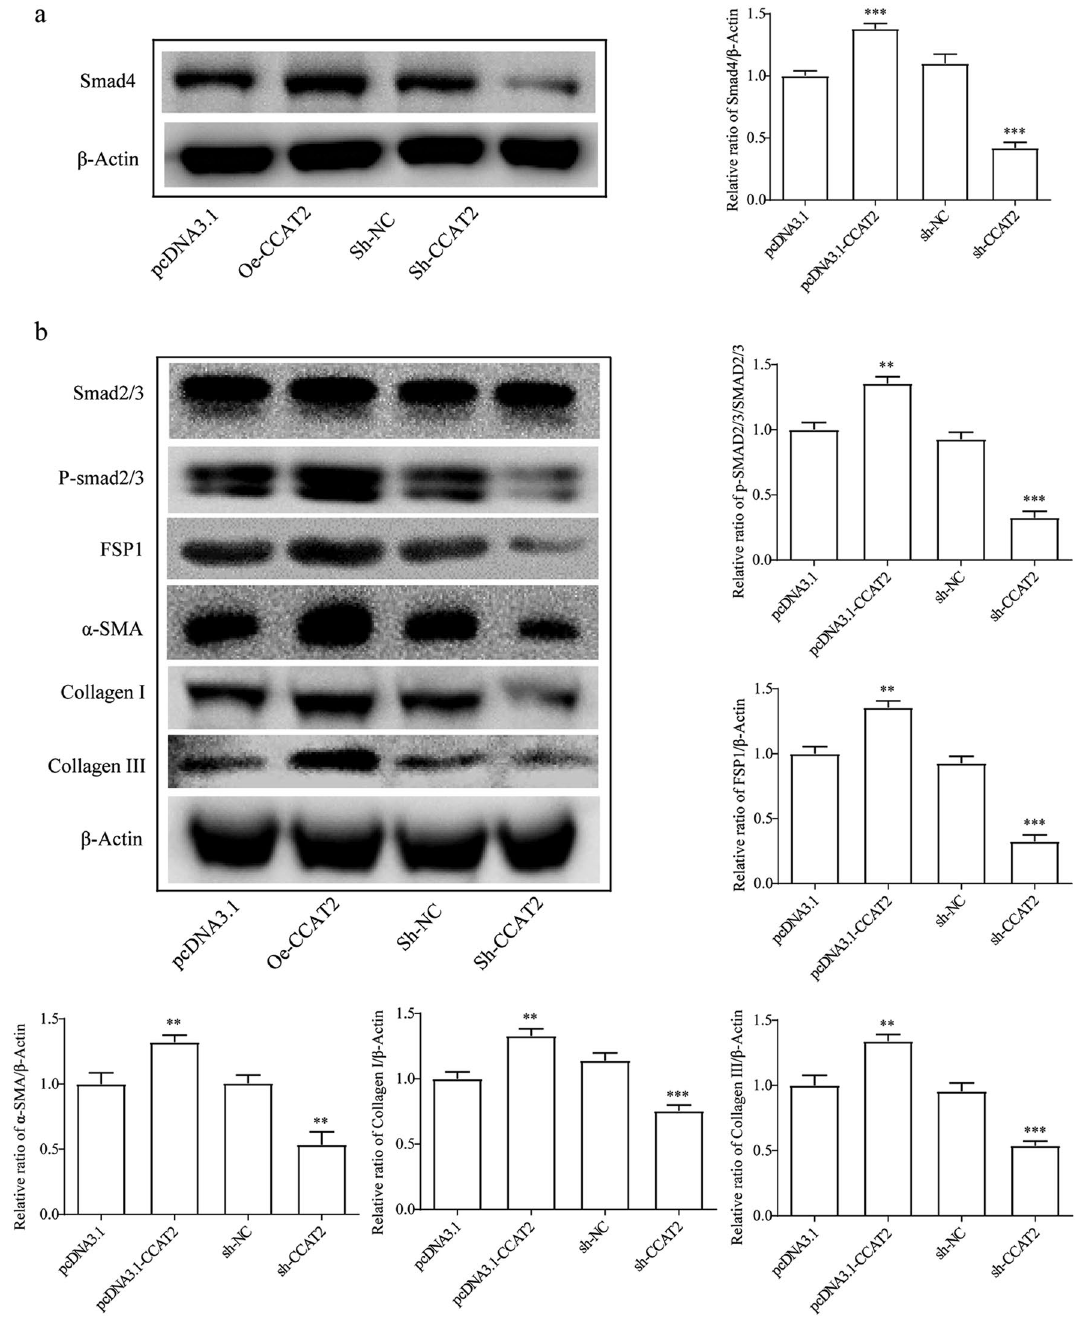
Figure 2. CCAT2 regulates EMT related proteins and Smad signaling in HSCs. β-actin was used as an internal control. Data are reported as means ±